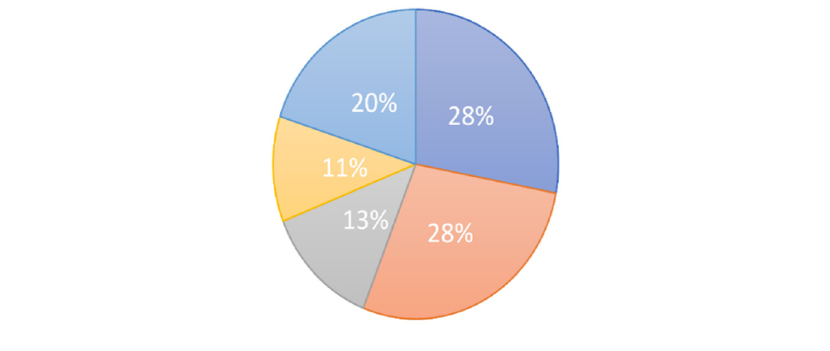
Figure 4. Distribution of the barriers within lung cancer care continuum.